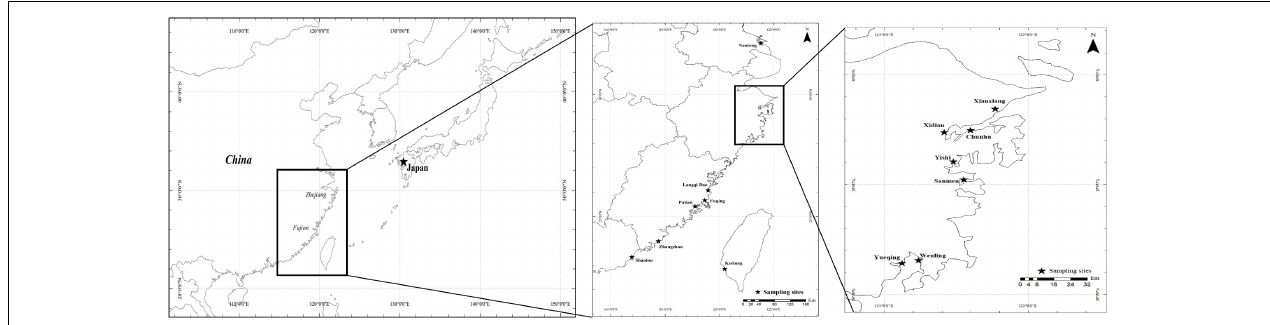
FIGURE 1 | Geographic location in this study, the main aquaculture bay—Xiangshan bay, Sanmen bay and Yueqing bay in the coast of Zhejiang Province as well as other related location including samples in Fujian province and Nantong.